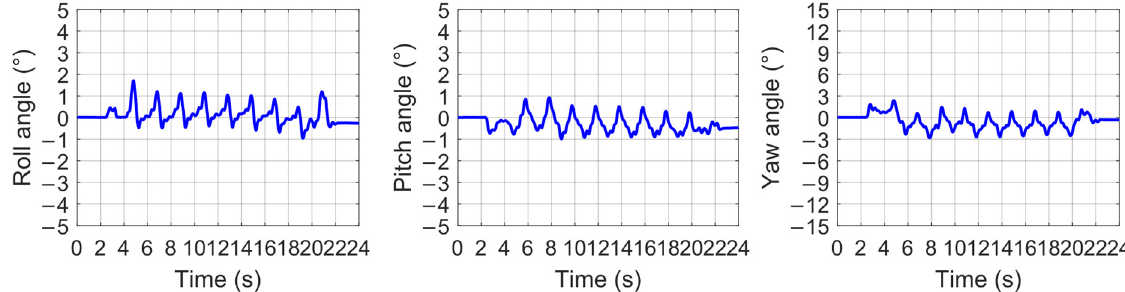
Figure 16. Attitude variations in tripod gait (with correction).